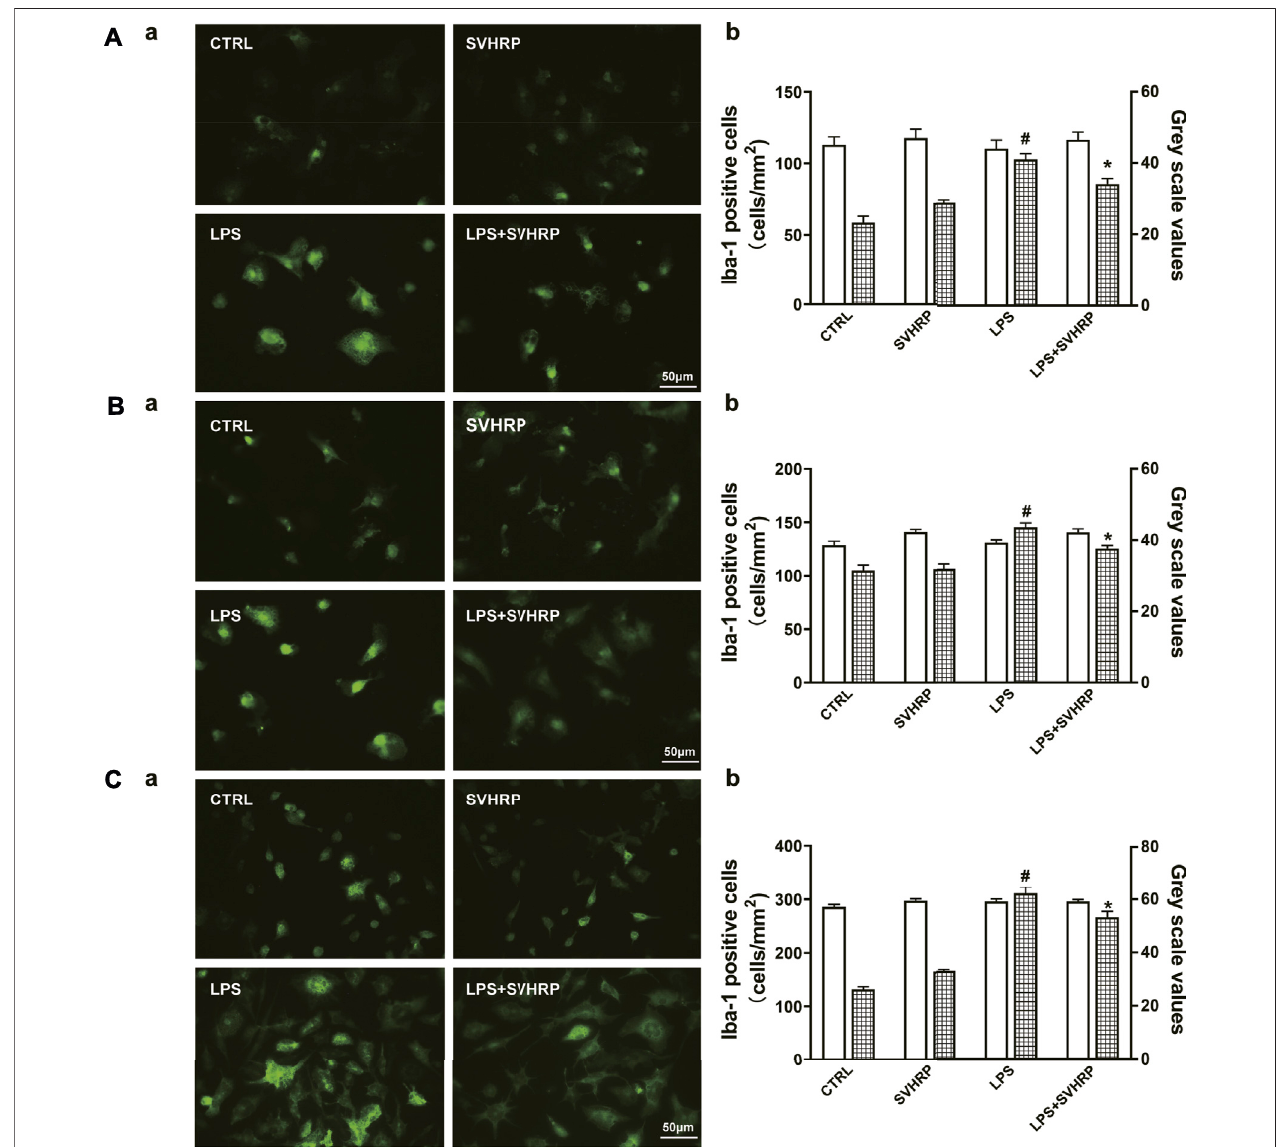
FIGURE2| SVHRPattenuatesLPS-inducedupregulationofIba-1inmicroglia.IFstainingforIba-1inprimaryneuron-glia (A) ,mixedglia (B) ,andenrichedmicroglia (C) cultureswereperformed24 hafterLPStreatment.CellswerepretreatedwithvehicleorSVHRP(20 μ g/ml)for1 hbeforeLPSchallenge. (a) Representativeimagesof Iba-1 positive cells (400 × , Bar (cid:2) 50 μ m). (b) Cell number and average grey scale for Iba-1 staining were shown. The data were the means ± SEM ( n ≥ 3 for each cell preparation). # p < 0.05 compared with CTRL group, * p < 0.05 compared with LPS group.